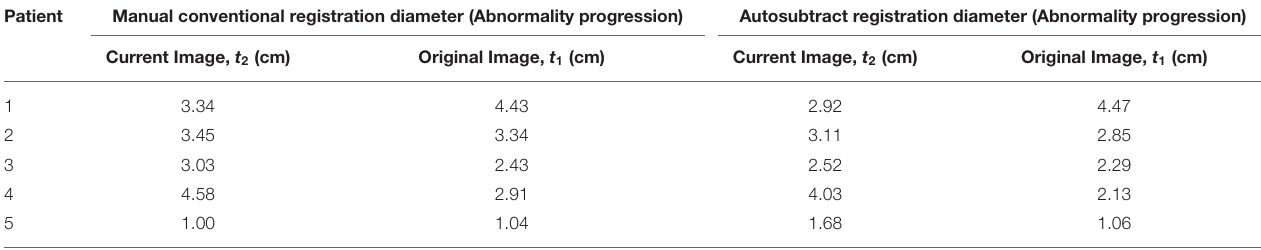
TABLE 3 | Diameter difference of tumour between manual conventional reading and digital image subtraction technique. Patient Manual conventional registration diameter (Abnormality progression) Current Image, t 2 (cm)